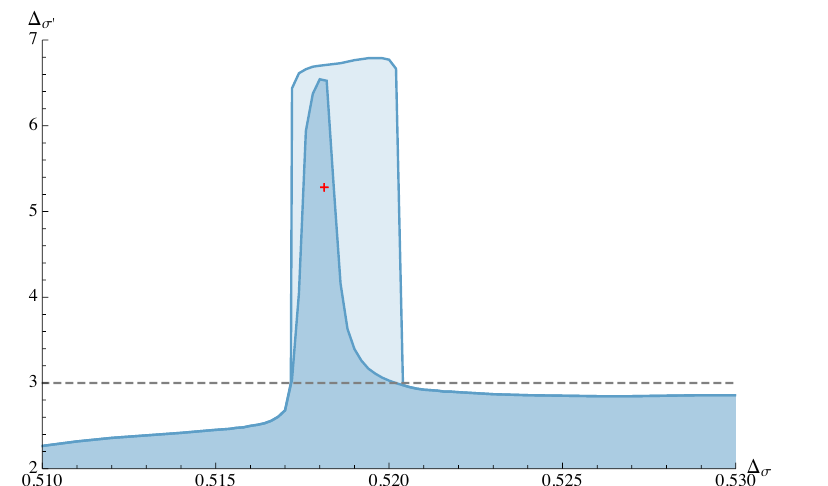
Figure 6 . Upper bound on the dimension of the (cid:12)rst parity odd scalar (cid:27) 0 appearing in the OPE (5.22) assuming that (cid:1) (cid:15) saturates the bound shown in (cid:12)gure 3 of [47]. Light blue has no further assumptions. Dark blue assumes a gap in the Z 2 -odd spin-1 sector (cid:1) ‘ =1